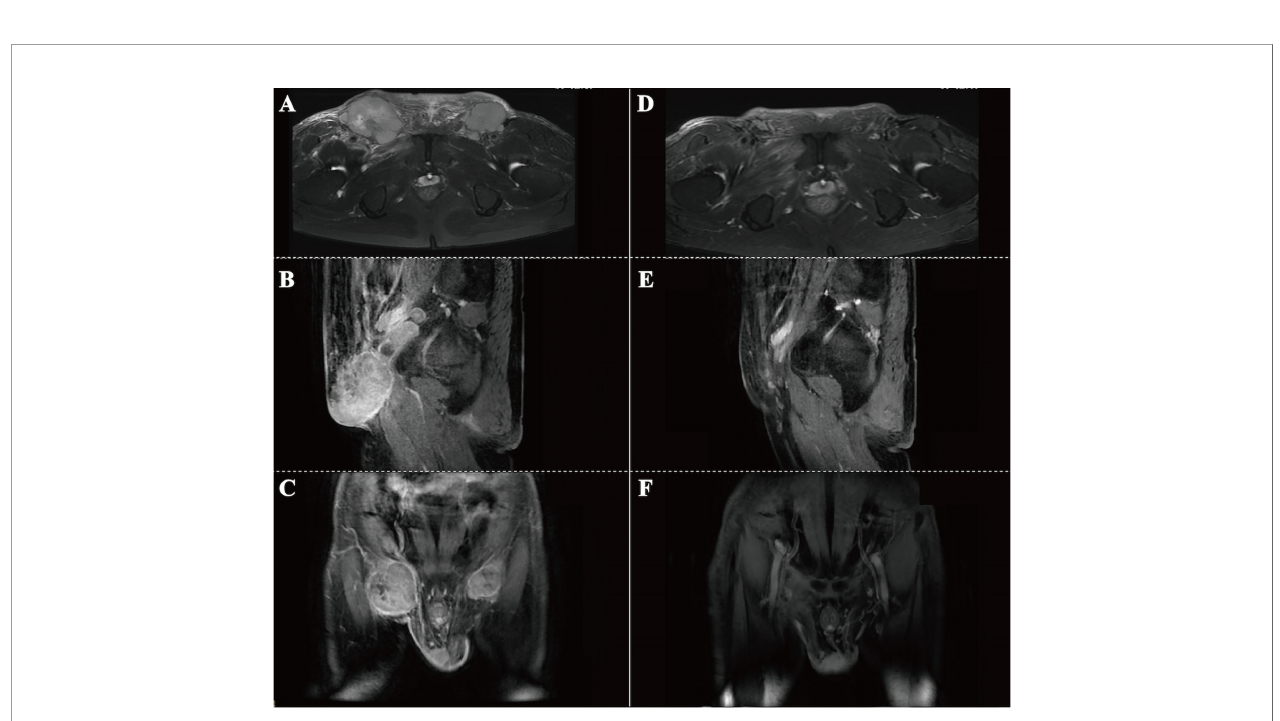
FIGURE 3 | Pelvic MRI results. (A-C) MRI before treatment on June 12, 2021. Horizontal (A) , sagittal (B) and coronal (C) images showing multiple enlarged lymph nodes in the groin area on both sides. (D-F) MRI after 2-cycle treatment on August 7, 2021. Horizontal (D) , sagittal (E) and coronal (F) images showing the disappearance of swollen inguinal lymph nodes in the